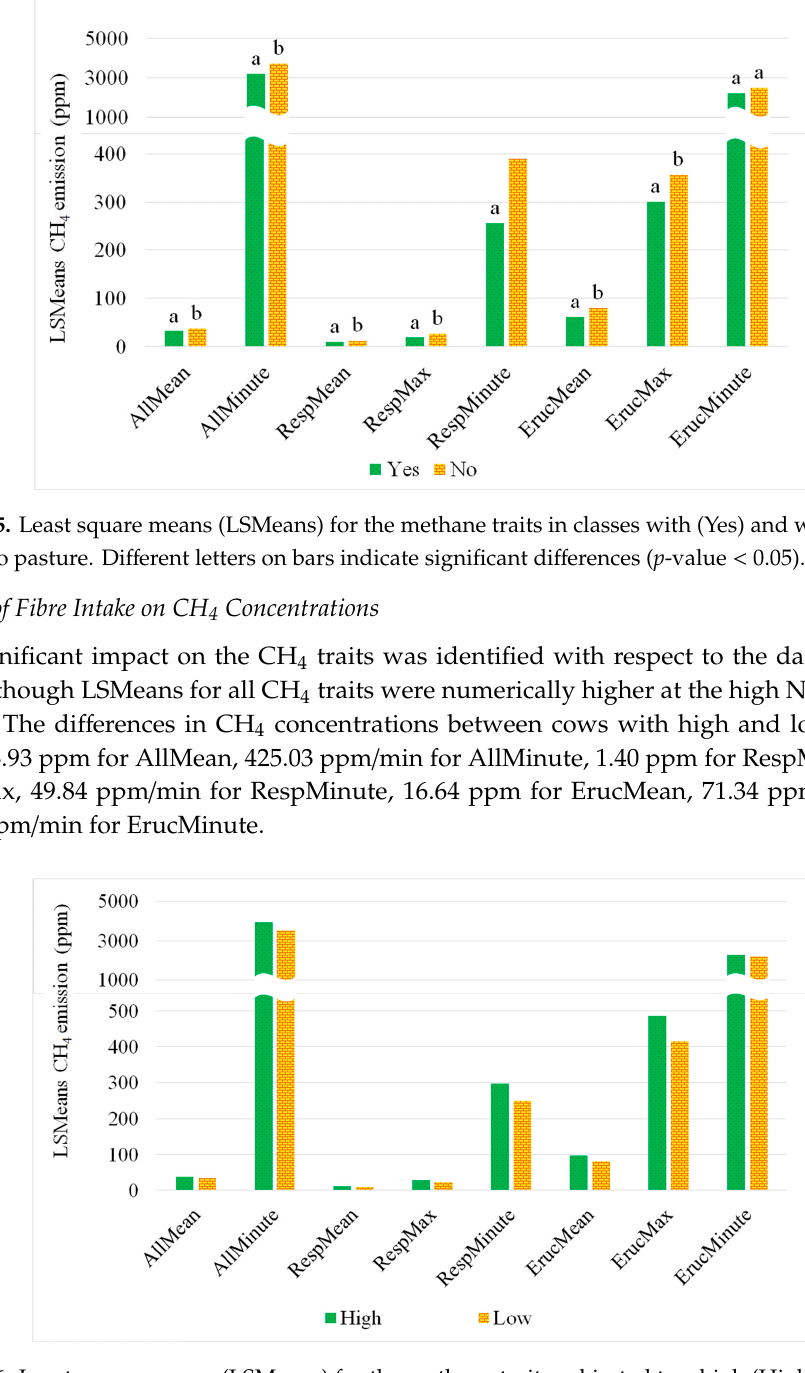
Figure 4. Least square means (LSMeans) for the methane traits in indoor, half-outdoor and outdoor classes. Different letters on bars indicate significant differences ( p- value < 0.05).